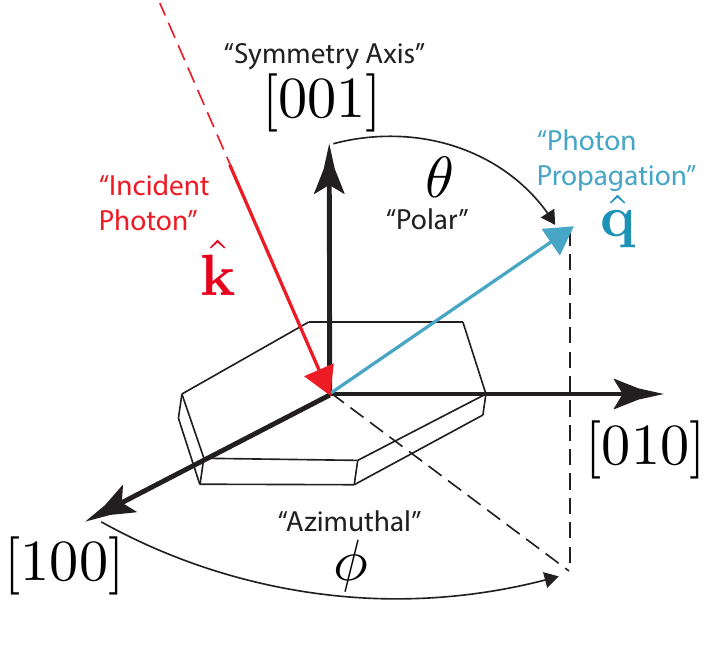
Figure 1. Orientation of incident photons and propagation direction for a hexagonal